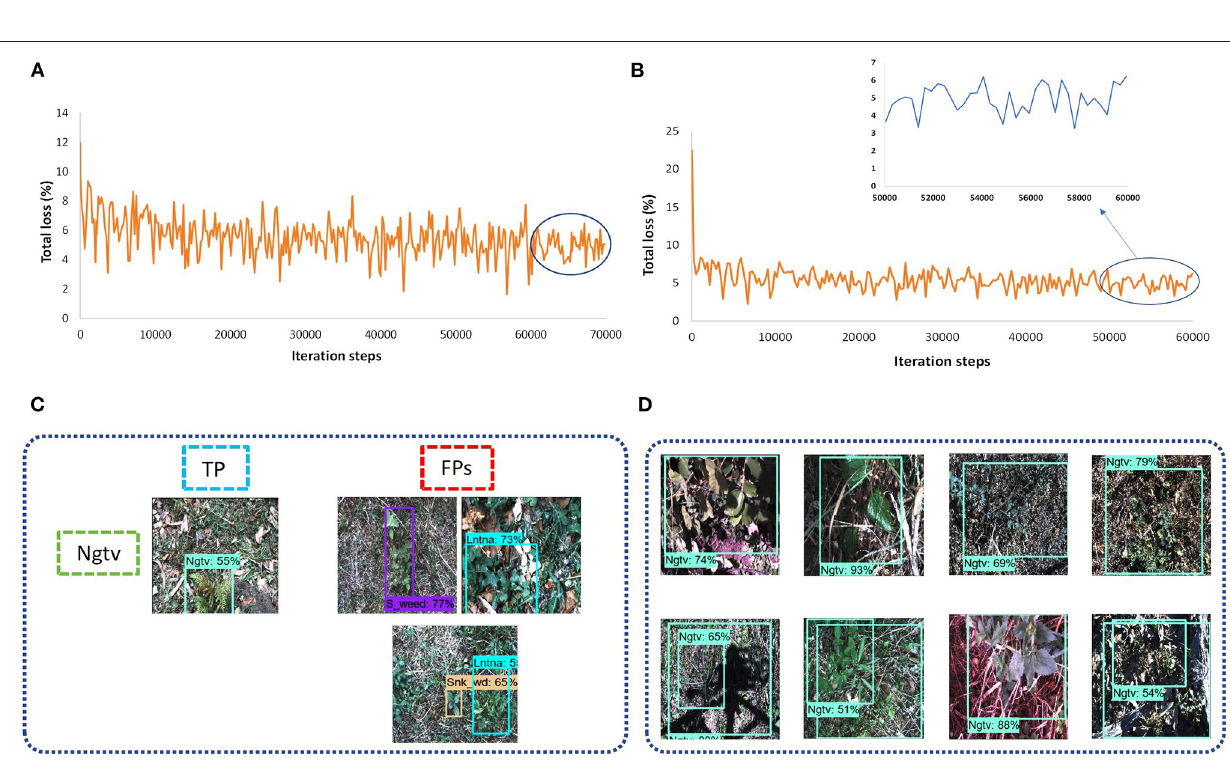
FIGURE 4 | Performance of the single-shot multibox detector (SSD) architecture: (A) total loss with the Inception model; (B) total loss with the MobileNet model; (C) examples of a false-positive result for the negative class with the Inception-v2 model; (D) example of false positives for the eight classes of weeds with the MobileNet model. TP: true positive, FP: false